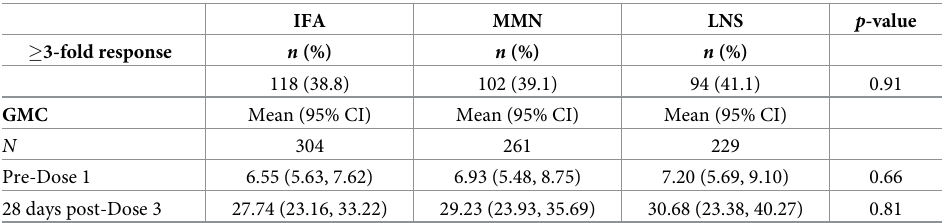
Table 2. Serum IgA seroconversion and mean concentration at Dose 1 and 28 days post-Dose 3 among vaccinated infants by prenatal supplementation